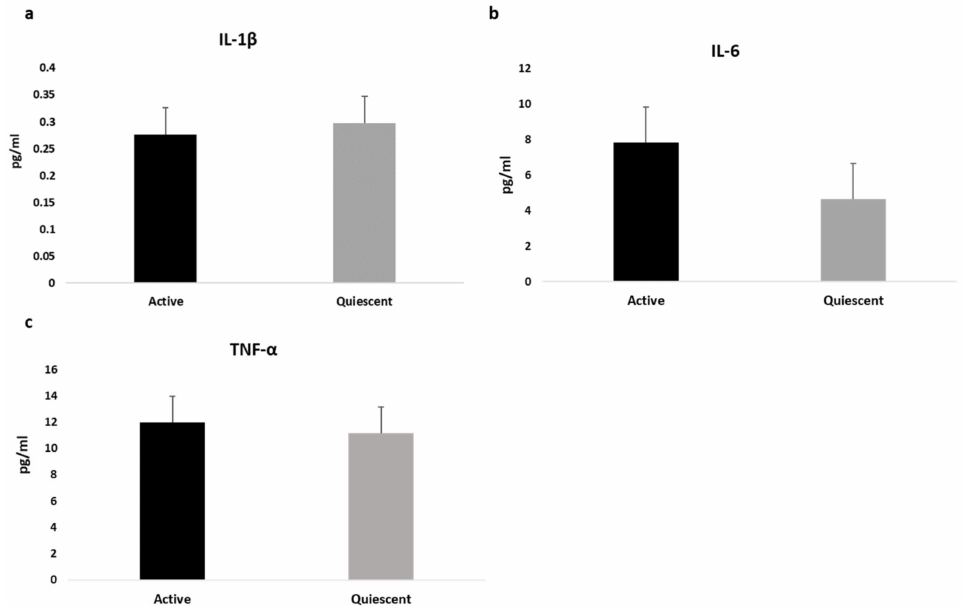
Figure 1. Differences in cytokines values between active and quiescent CD patients, adjusted by sex and treatment. Data are expressed as estimated means and standard error (SE) for Interleukin-1 β ( a ), Interlukin-6 ( b ) and Tumor Necrosis Factor-Alfa ( c